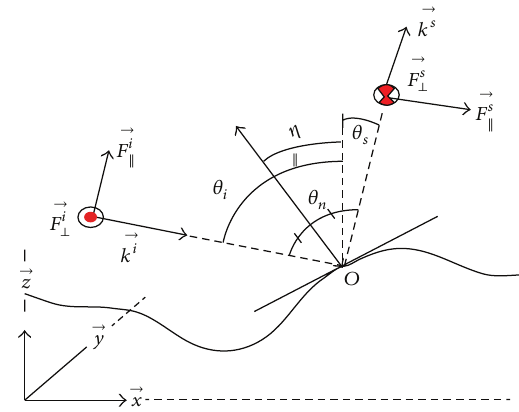
Figure 4: Notations used in the KA based scattering